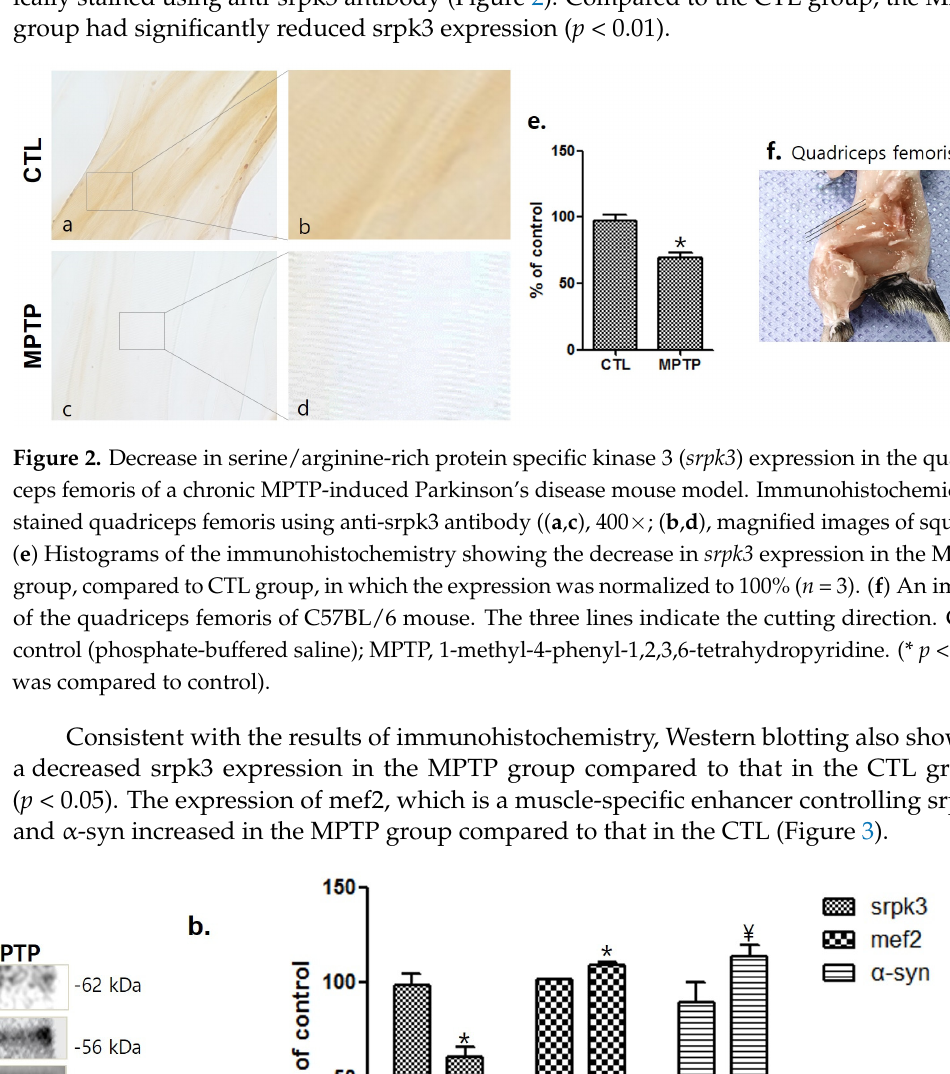
Figure 3. Decrease in serine/arginine-rich protein specific kinase 3 ( srpk3 ) expression in the quadriceps femoris of an MPTP-induced parkinsonism mouse model. ( a ) The results of the Western blot are shown. ( b ) Histograms of the Western